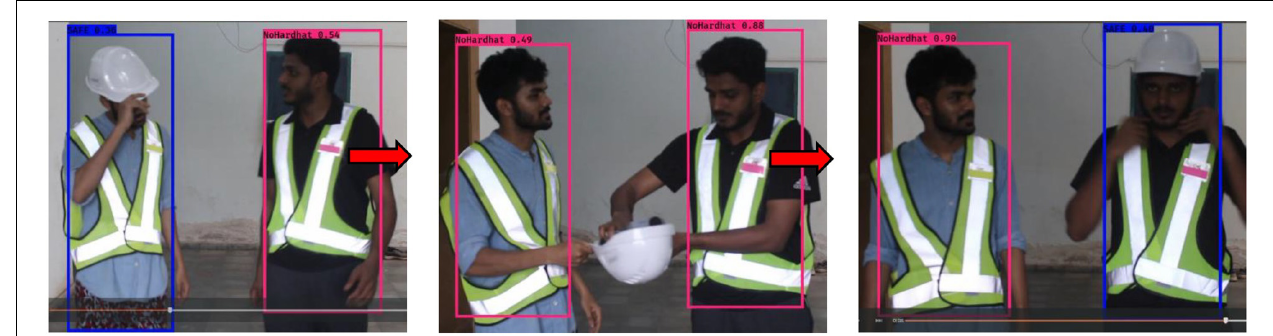
FIGURE 4 | Sample demonstration of the prediction of the developed model.